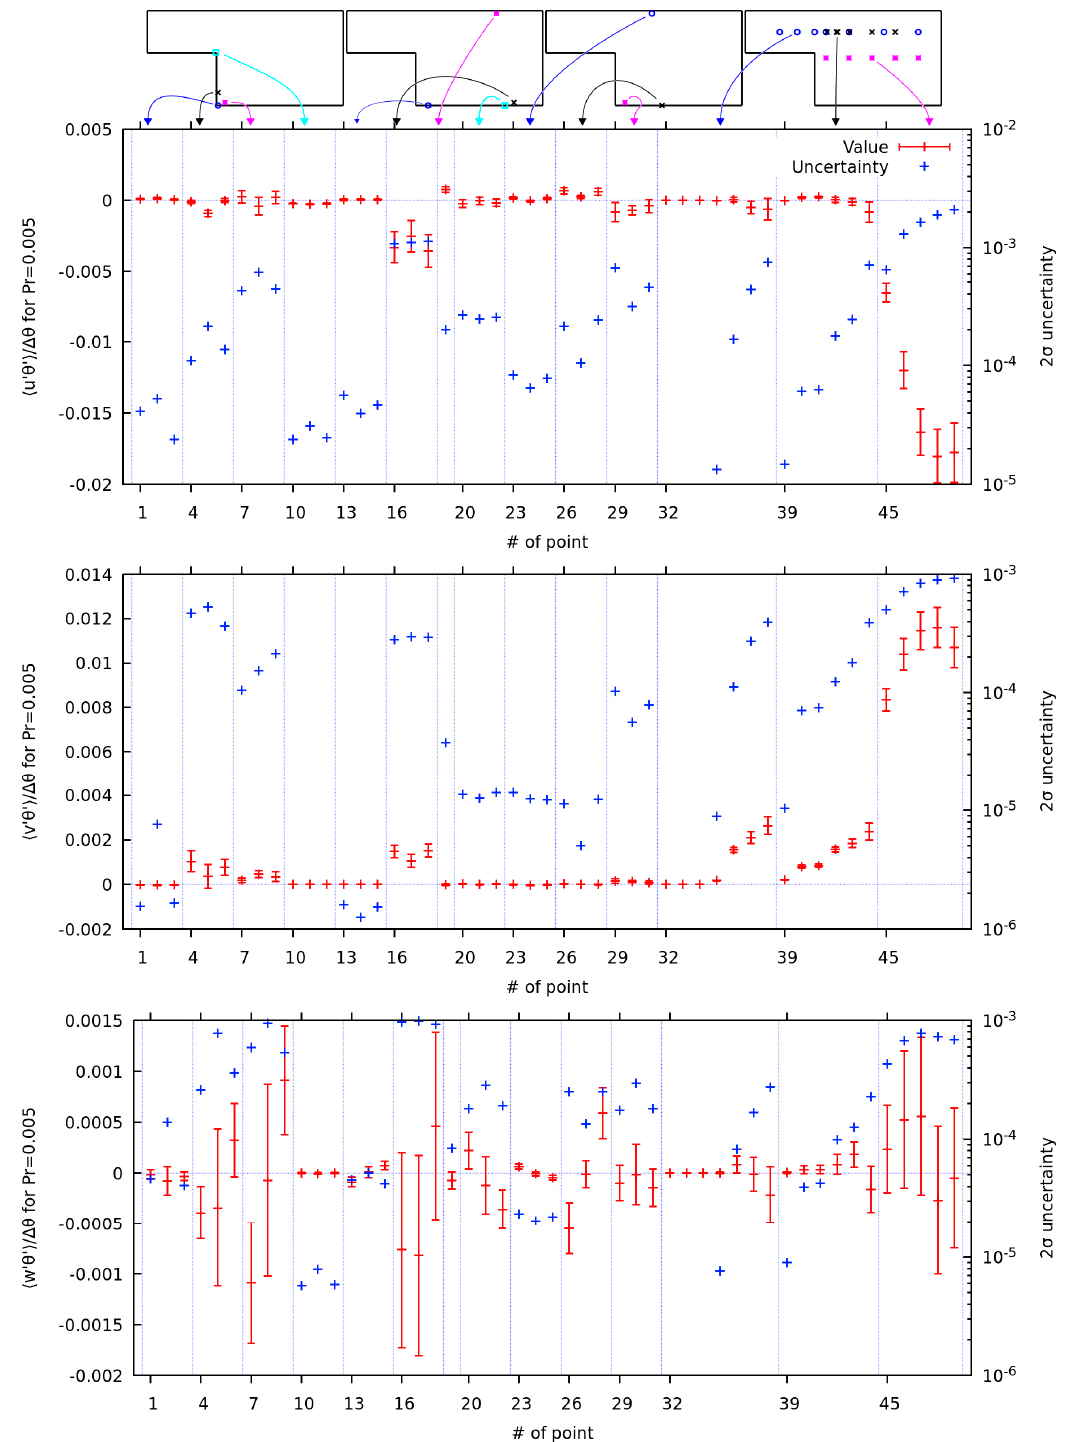
Figure A2. 𝑥 -axis: number of point according to Figure 2. Top to bottom: turbulent heat flux components for Pr = 0.005 : Figure A2. x -axis: number of point according to Figure 2. Top to bottom: turbulent heat flux components for Pr = 0.005: 〈𝑢 (cid:4593) 𝜃 (cid:4593) 〉 , 〈𝑣 (cid:4593) 𝜃 (cid:4593) 〉 and 〈𝑤 (cid:4593) 𝜃 (cid:4593) 〉 . Red dots represent root-mean-square values with ± 2𝜎 range (left scale), green dots represent (cid:104) u (cid:48) θ (cid:48) (cid:105) , (cid:104) v (cid:48) θ (cid:48) (cid:105) and (cid:104) w (cid:48) θ (cid:48) (cid:105) . Red dots represent root-mean-square values with ± 2 σ range (left scale), green dots represent (2 σ ) ( 2𝜎 ) uncertainty (right scale). uncertainty (right